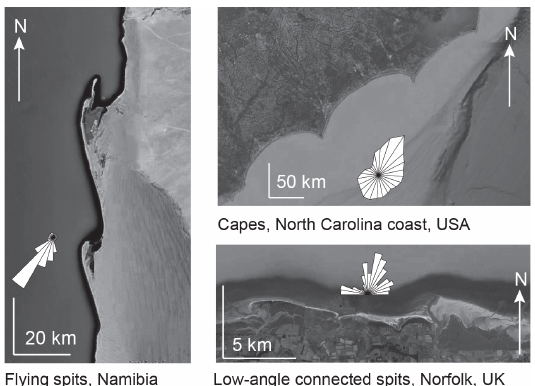
Figure 1. Diverse large-scale morphologies developed on open sandy coastlines under the influence of dominantly high-angle off- shore waves ( U > 0 . 5). Spits develop under an asymmetric distri- bution of wave angles ( A ∼ 0 . 7); nearly symmetric capes develop where the wave angles are distributed symmetrically ( A ∼ 0 . 5). Representative wave angle distributions are taken from wave buoy data available for these examples. Namibia: after Bosman and Jou- bert (2008). North Carolina capes, USA: WIS station 509, after Ashton and Murray (2006b). North Norfolk, UK: data from Blak- eney Overfalls Waverider III buoy, Cefas